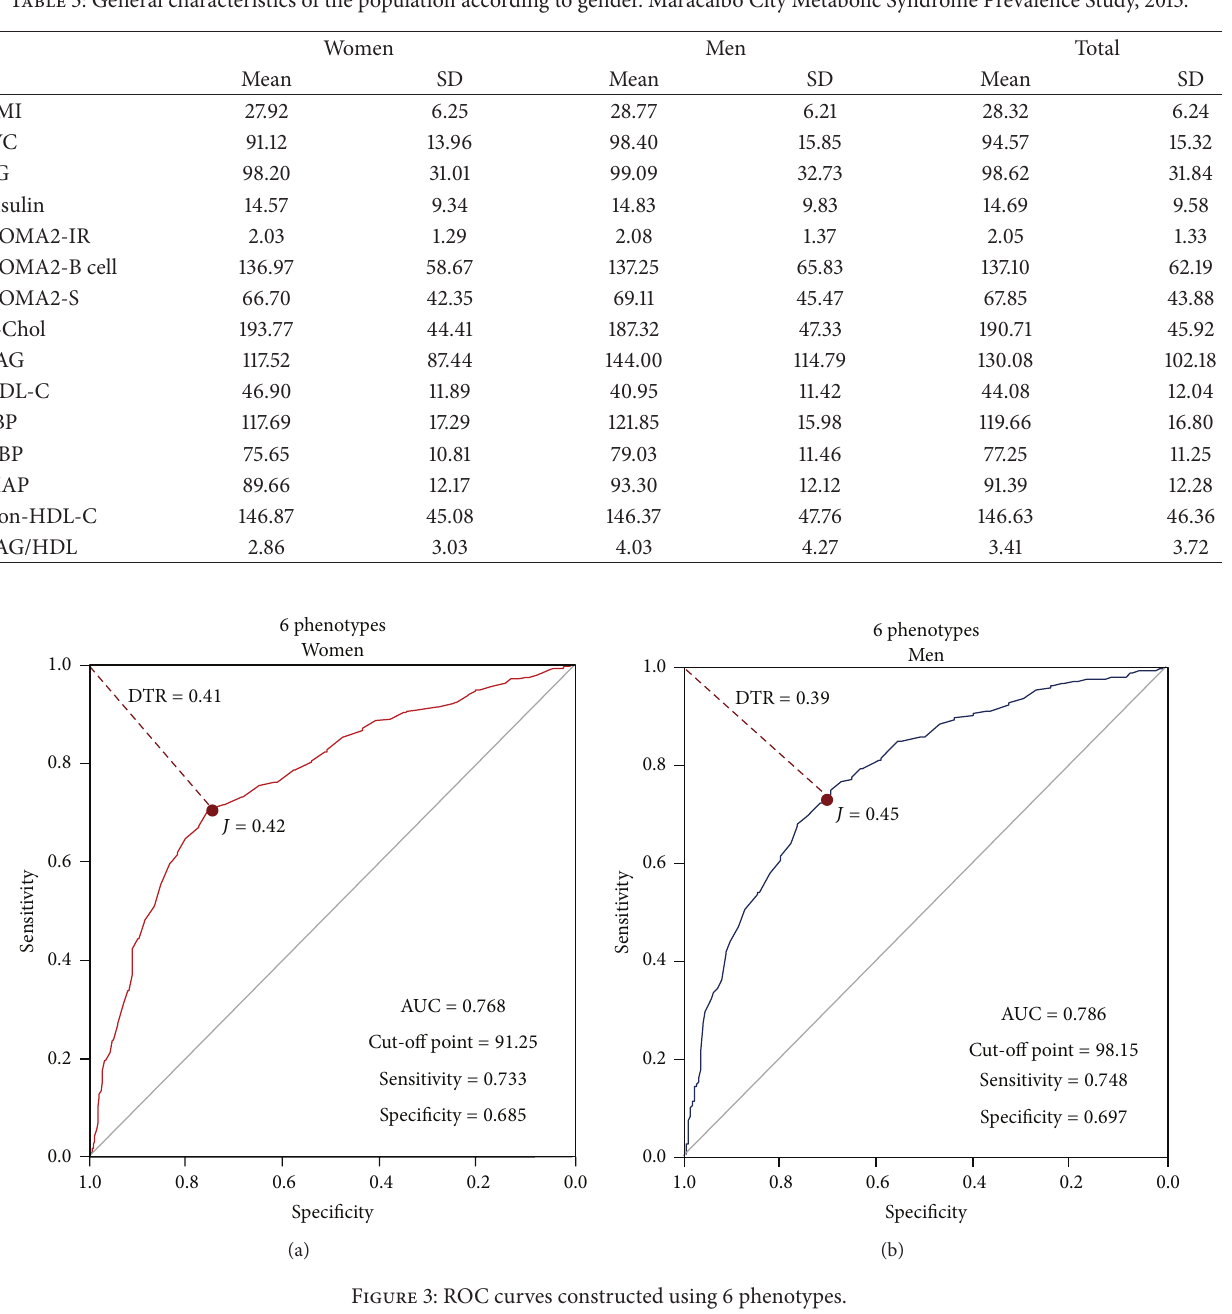
Table 3: General characteristics of the population according to gender. Maracaibo City Metabolic Syndrome Prevalence Study, 2013.